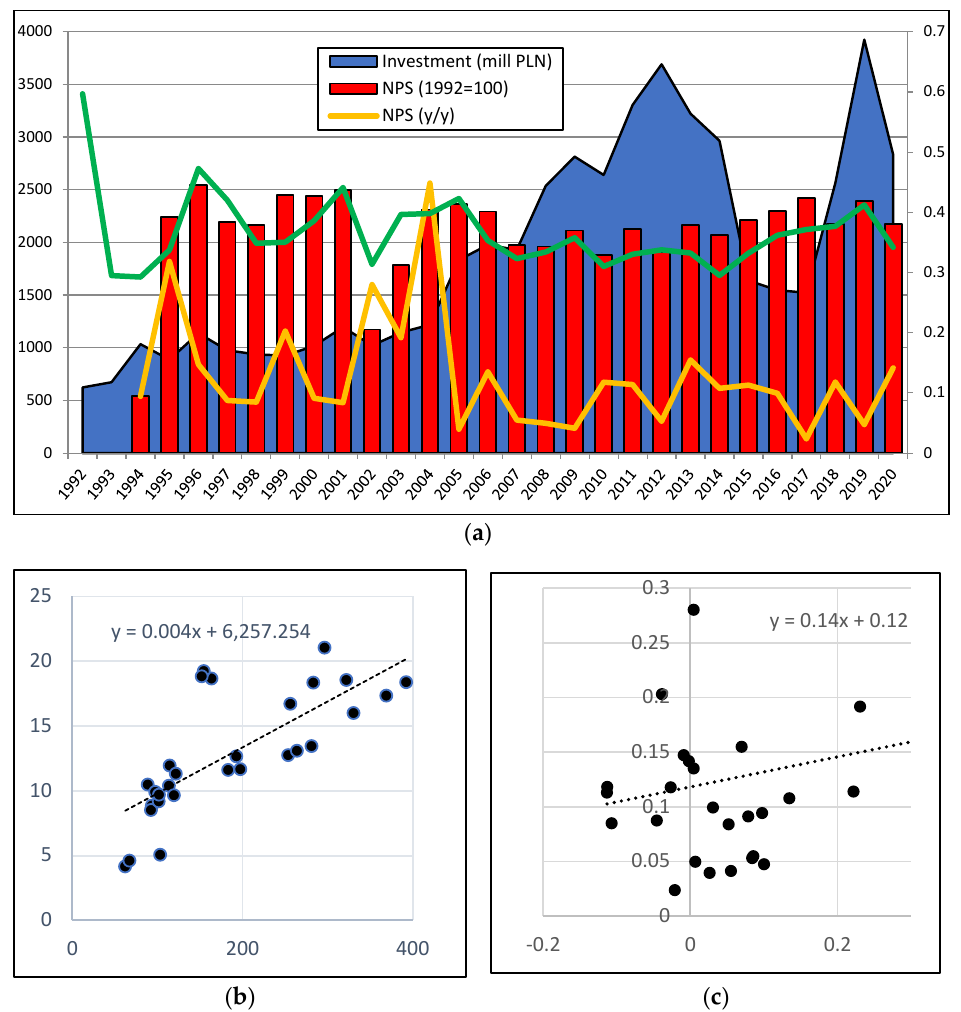
Figure 7. Investment outlays for mining enterprises in Poland in 1992 – 2020; ( a ) Capital expenditure, intensity of structure changes (NPS 1992 = 100, NPS y/y), and concentration (HHI); ( b ) Regression curve for investment outlays and net fixed assets values; ( c ) Regression curve of the intensity of changes in the structure of investment outlays and the rate of changes in the net fixed assets. Notes: investment outlays — left axis. Remaining remarks as to Figure 5. Source: as in Figure 5.